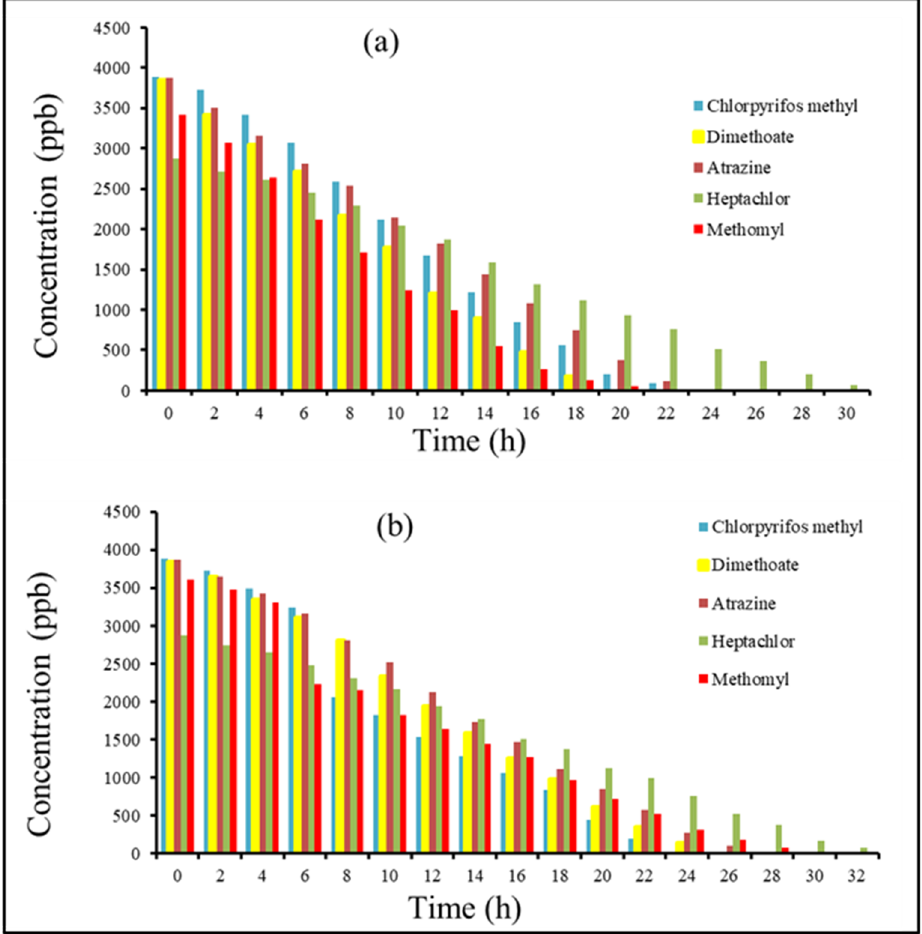
Figure 5. Variation of the concentration of the pesticides as a function of time under UV irradiation in ( a ) presence of TiO 2 and ( b ) ZnO.